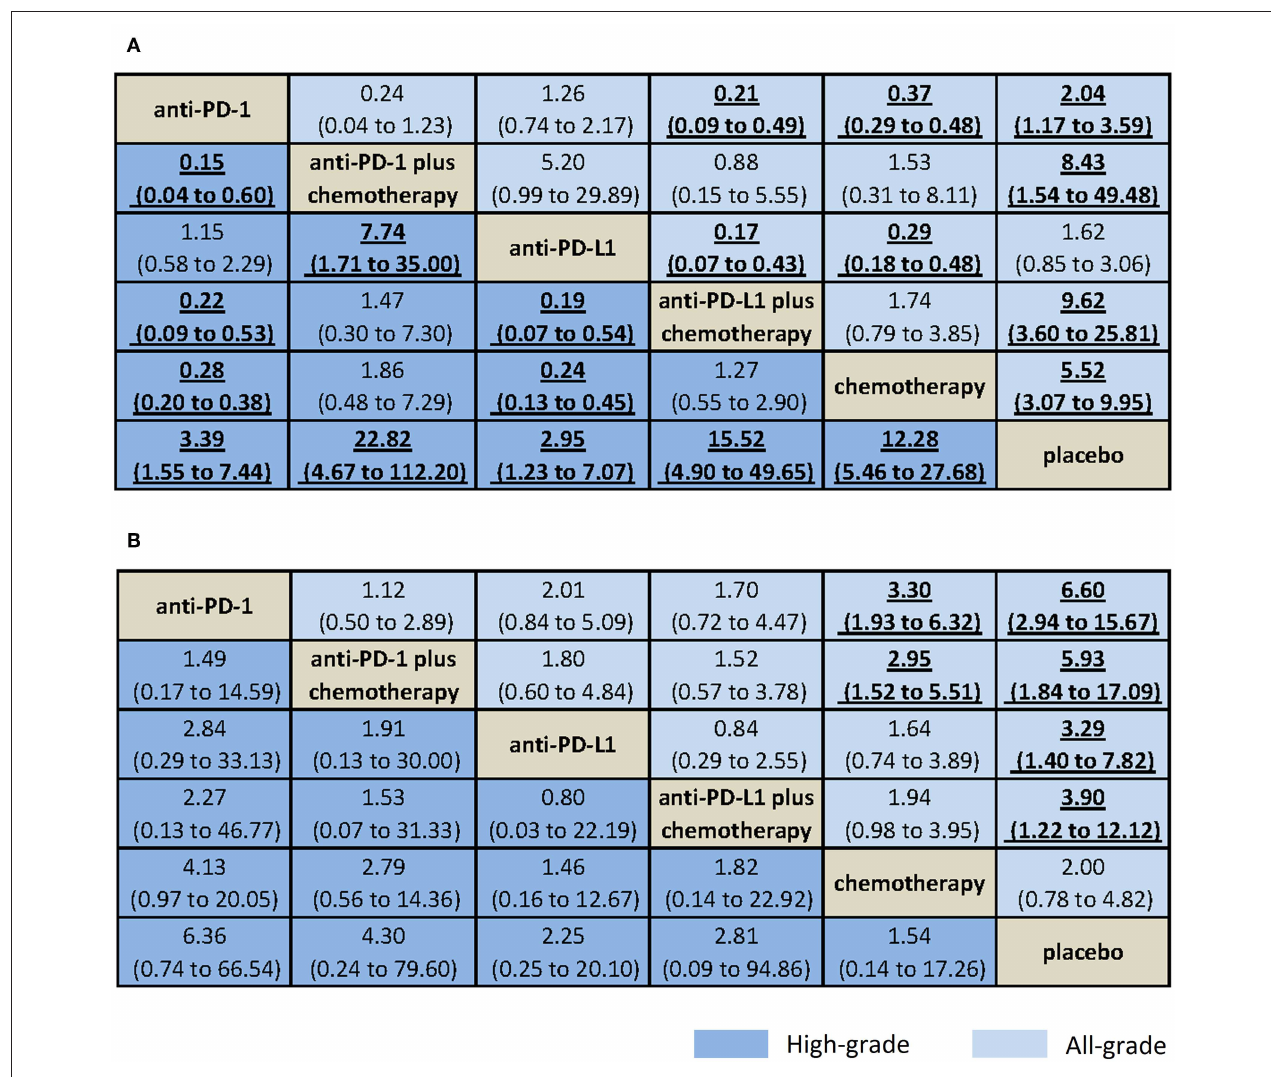
FIGURE 3 | Bayesian network meta-analysis of treatment-related and immune-related adverse events. Comparisons should be read from the top treatment to the bottom treatment. Bold underline cells are significant. Results represent pooled odds ratios and 95% credible intervals for treatment-related adverse events (A) and immune-related adverse events (B) . Odds ratio > 1 favors the bottom